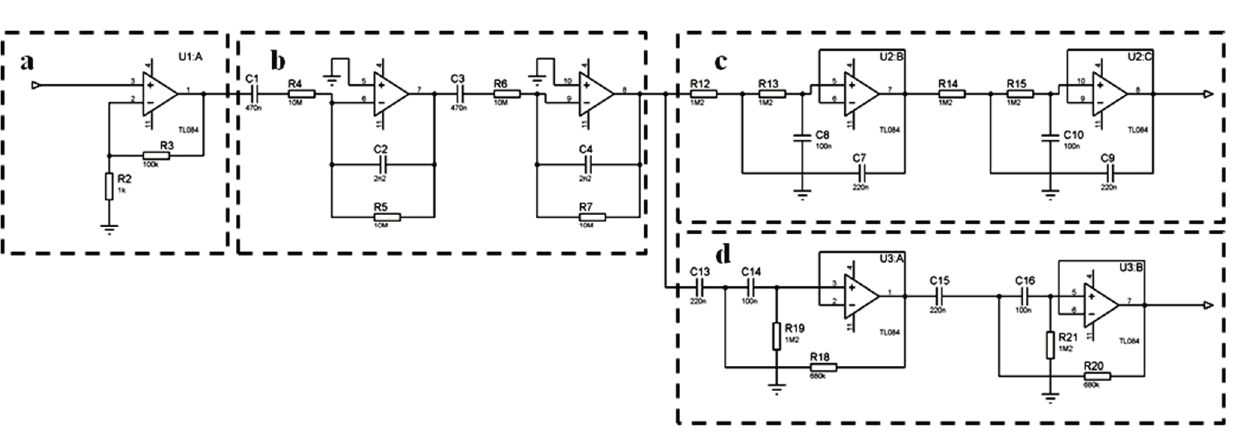
Figure 6. Amplifying stage ( a ), second order cascade filtering from 0.03 Hz to 7.2 Hz ( b ); second order filters in cascade for respiratory rate ( c ) and for heart rate ( d ).